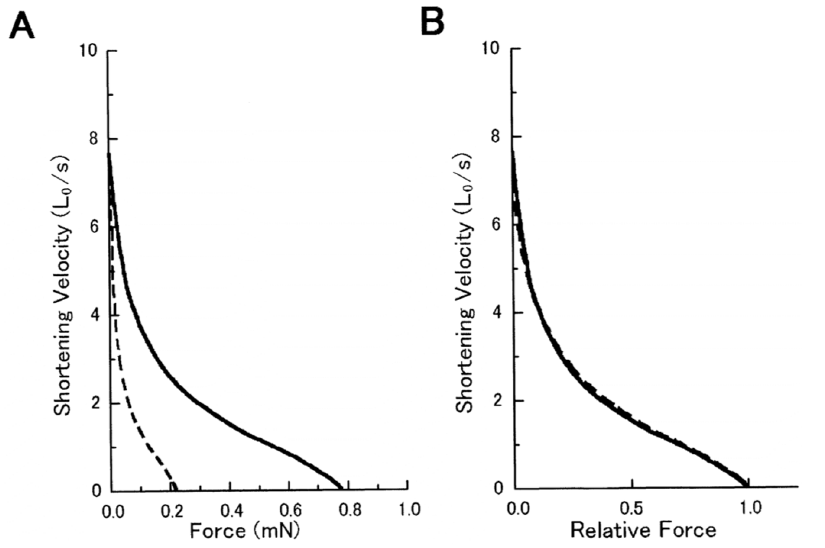
Figure 8. Effect of anti-LD antibody on force-velocity curves of a Ca 2 + -activated muscle fiber. (A) Force-velocity curves before (solid line) and after (broken line) application of the antibody (1.5 mg/ml). (B) The same force-velocity curves with force expressed relative to the maximum value.